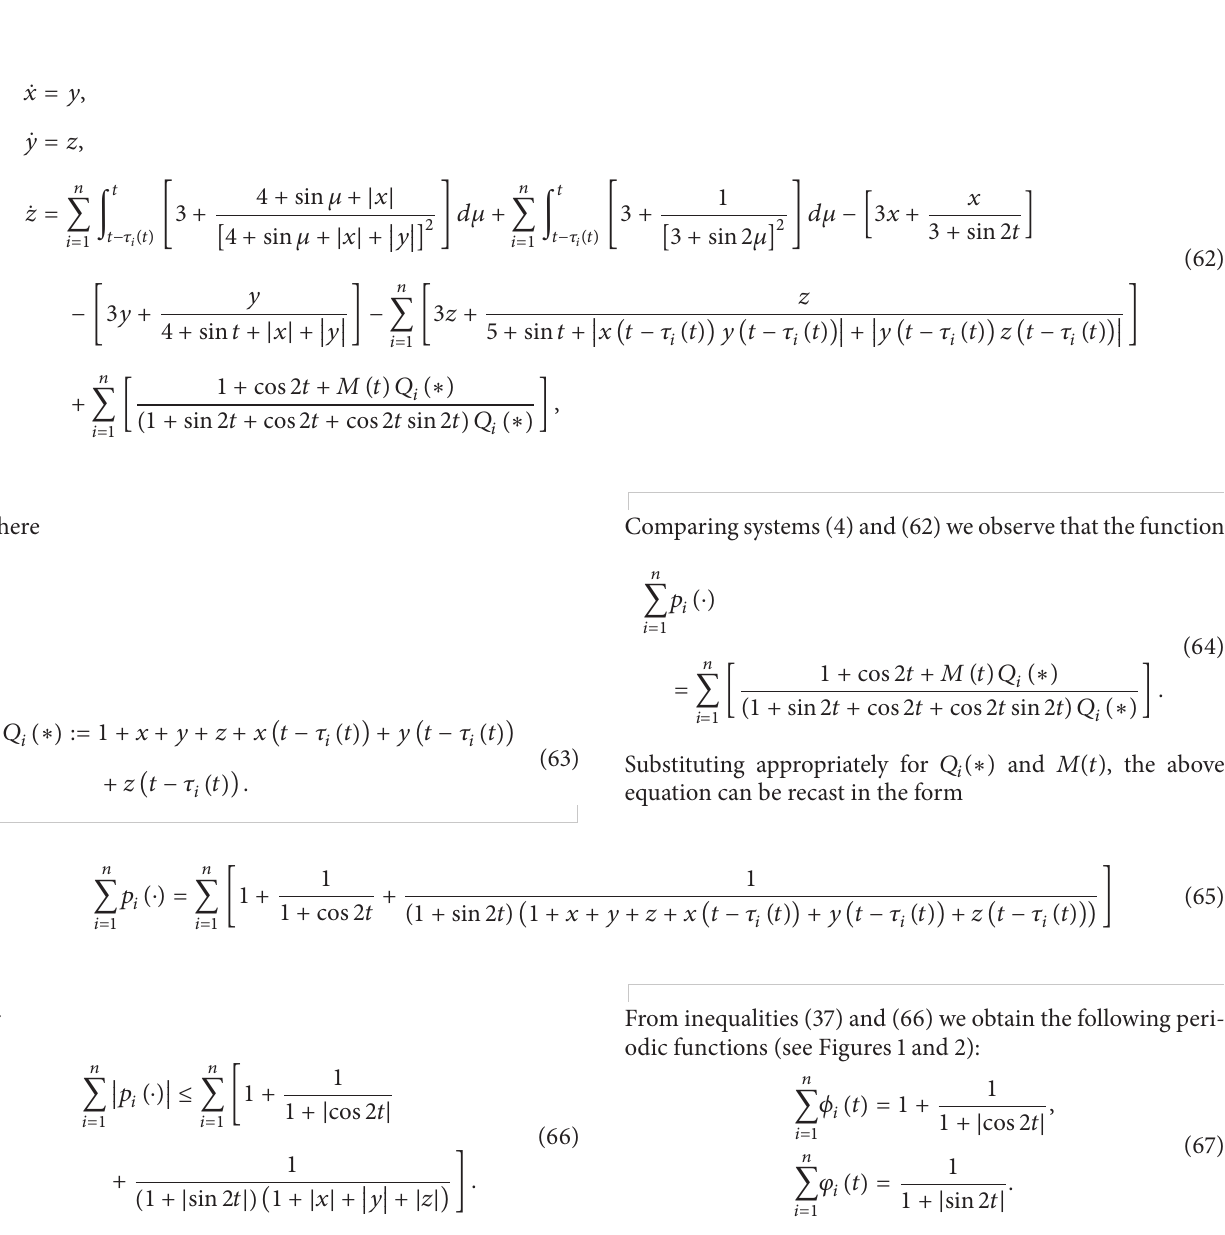
Figure 1: Periodic function 𝜙(𝑡) = 𝜙 𝑖 (𝑡)